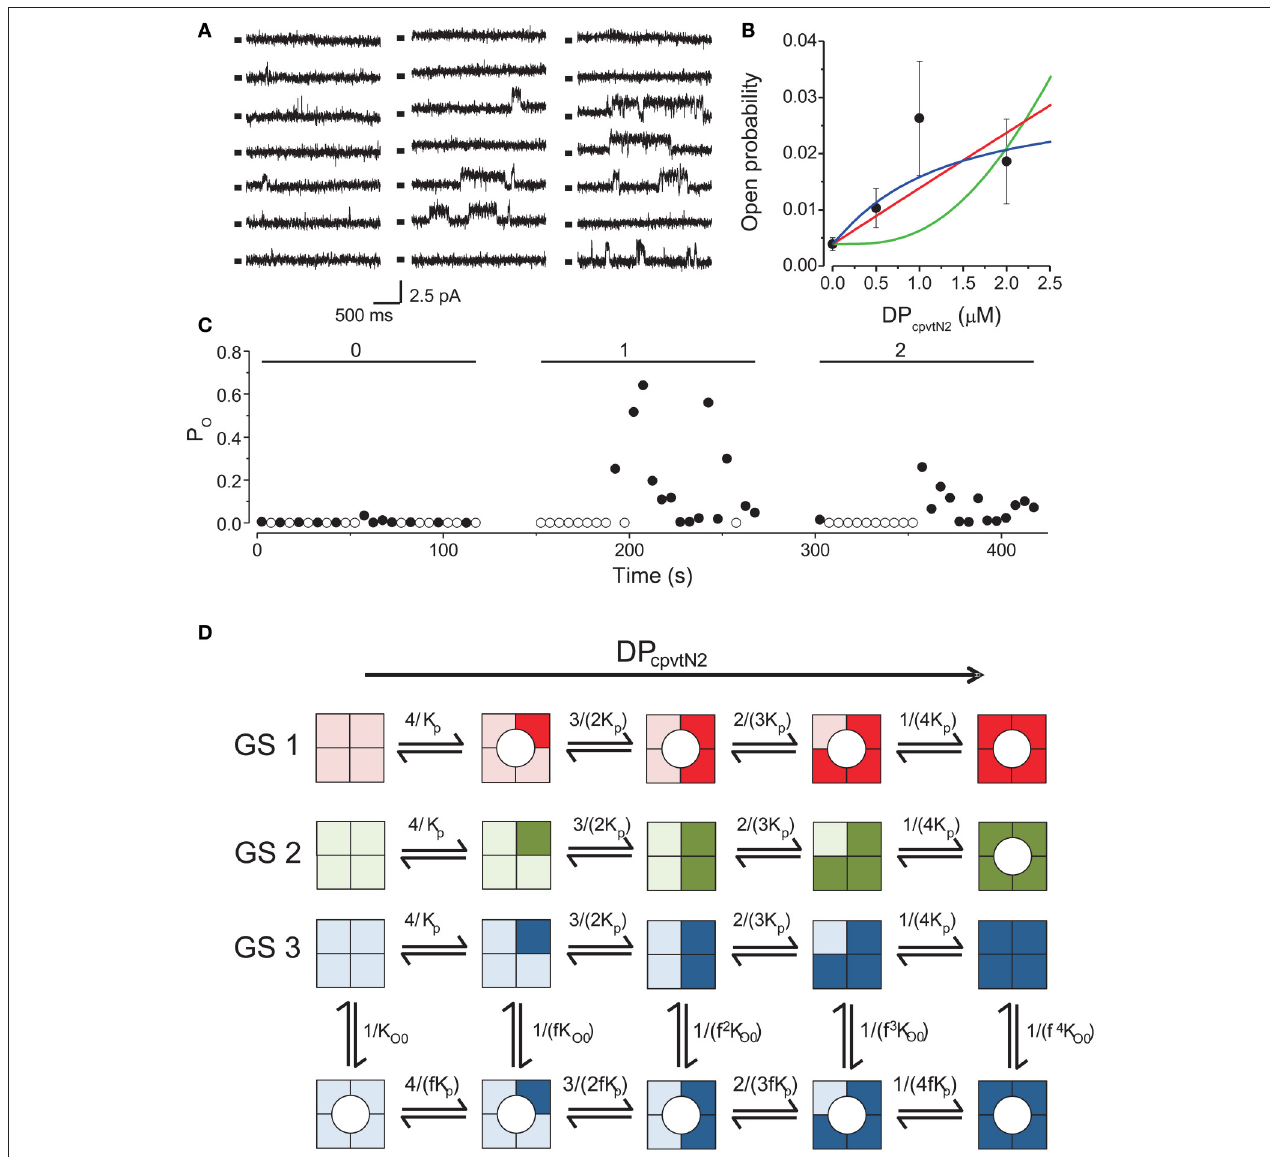
FIGURE 1 | Activation of RyR2 by the peptide DP cpvtN2 . (A) RyR2 activity at 0 mV under control conditions (left) and after addition of 1.0 µ M (center) or 2.0 µ M DP cpvtN2 (right). All records correspond to the same single channel. Markers indicate the closed state of the channel. (B) The concentration dependence of the effect of the domain peptide DP cpvtN2 on the open probability of the RyR2 channel ( n = 9 channels). Lines illustrate the fit of the data by gating schemes GS 1A (red; Equation 1), GS 1B (green; Equation 2) and GS 2 (blue; Equation 3) with parameters from Table 1 . (C) Time course of open probability changes induced by DP cpvtN2 in the RyR channel shown in (A) . The average open probability measured in 5-s segments is plotted against time after channel incorporation. Concentration of DP cpvtN2 (in µ M) is shown at the top. (D) Possible models of activation of the RyR2 by the peptide. Monomers with bound peptide are shown in a darker shade. Peptide-induced open state is denoted by a circle. GS 1 and GS 2 assume that the binding of peptide induces channel opening directly if any of the monomers is peptide-bound (GS 1) or if all four monomers have to be occupied by the peptide to induce channel opening (GS 2). GS 3 assumes an allosteric effect of the peptide, i.e., increase of the relative stability of the open state with increasing number of peptide-bound monomers. The formulae at individual reaction steps indicate the respective stepwise stability constants. The integers in the formulae in the numerator and denominator reflect the number of monomers undergoing the forward and backward transition, respectively. The names of the variables are explained in the legend to Equations (1)–(3).